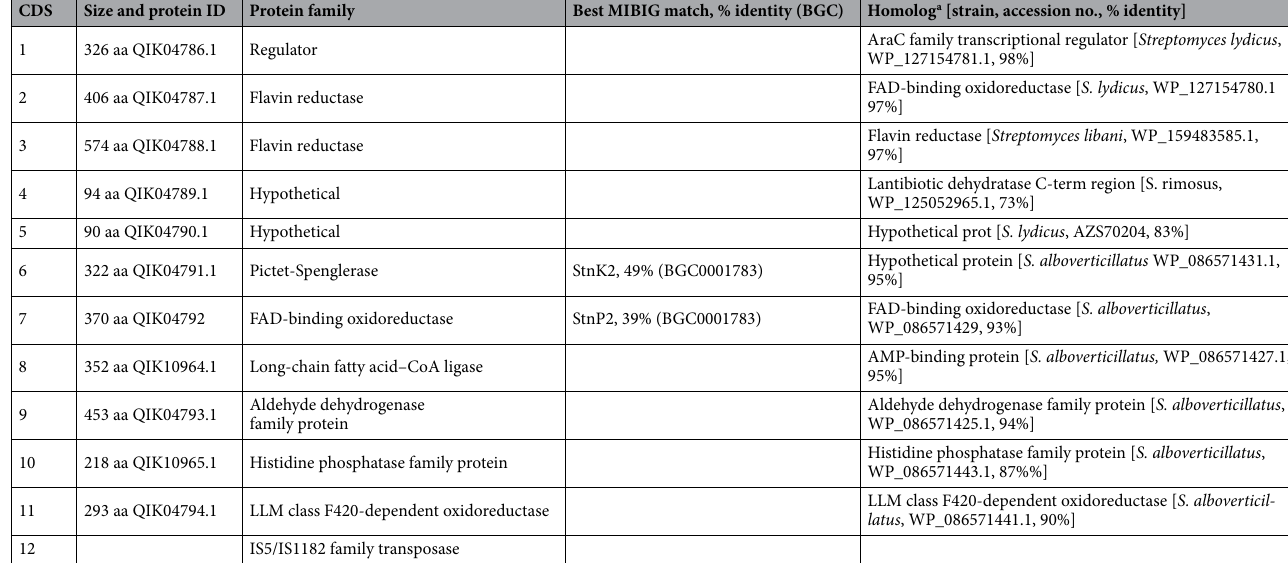
Table 4. The proposed pyridindolol BGC. a Matches to the syntenic S. alboverticillatus region shown in Fig. 2 are in